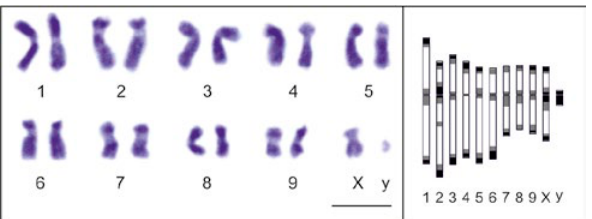
Fig. 2. Male karyotype and idiogram of A. velikensis 2n = 20. Bar = 5μm.